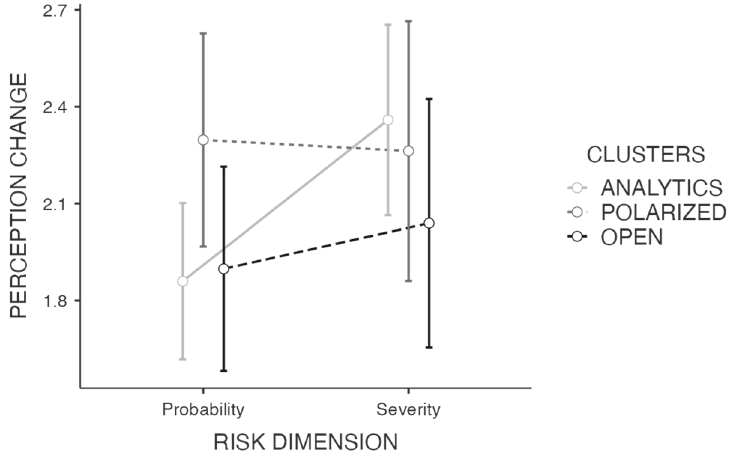
Figure 2. Comparison of the risk-perception (i.e., probability and severity) change between cluster profiles (i.e., analytics, polarized, open), with vaccine trust and conformism and high-intensity negative emotions as covariates.